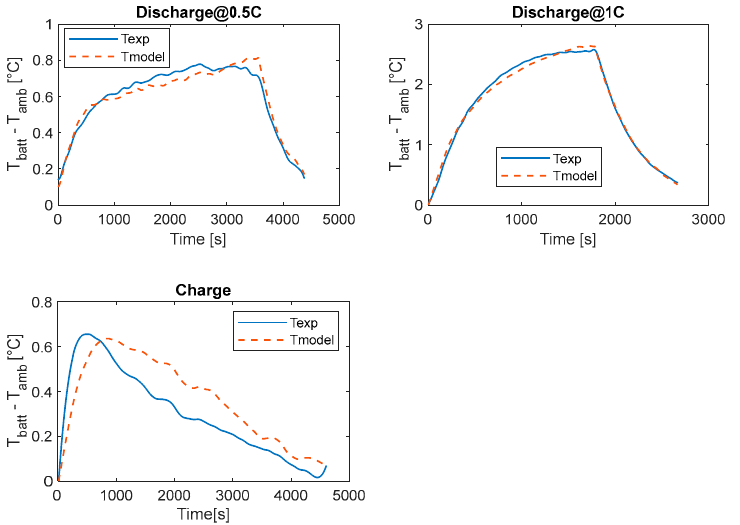
Figure 12. Comparison of the modeled and experimental transient of temperature for the battery under discharge at different loads ( top ) and under charge ( bottom ).